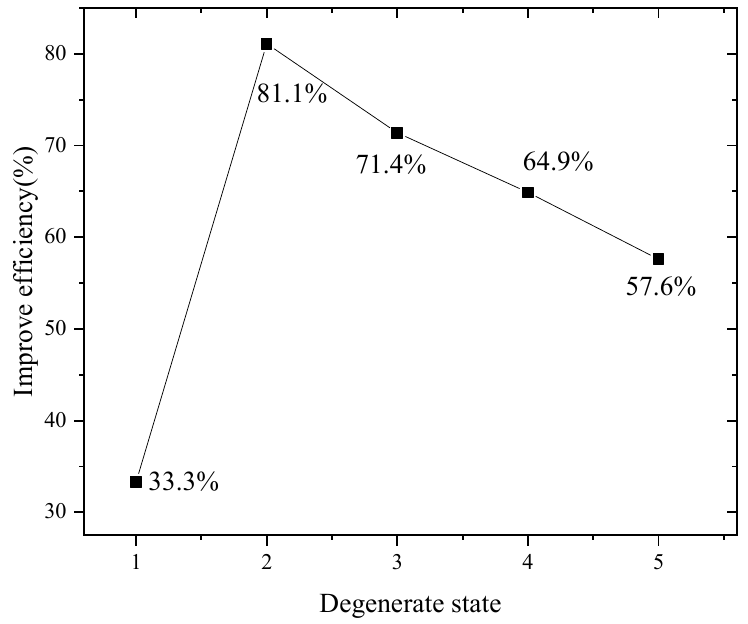
Figure 14. Improve efficiency by increasing the number of points.